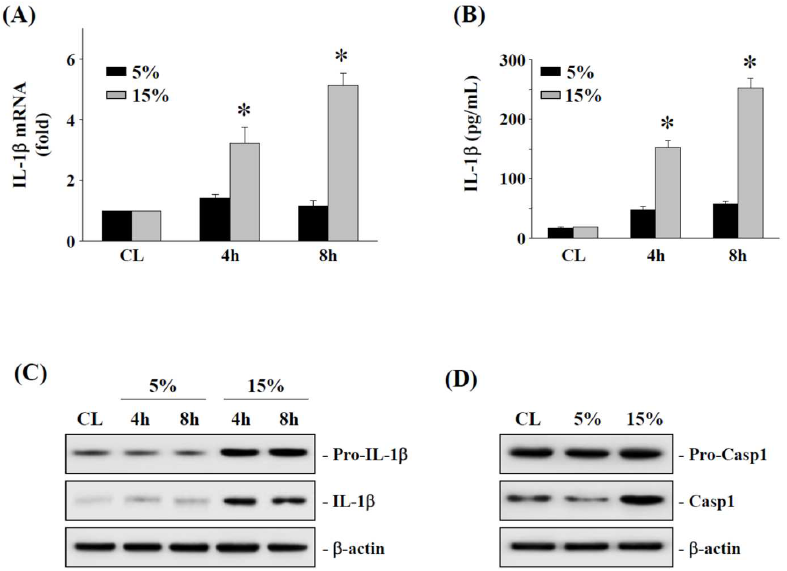
Figure 2. Induction of IL-1β expression in HAFCs exposed to 15% HCS. HAFCs were exposed to 5% or 15% cyclic stretch for the indicated times, and ( A ) the expression level of IL-1β mRNA were determined by real-time PCR analysis. ( B ) IL-1β secretion in medium was determined by ELISA analyses. The results are mean ± standard error of the mean (SEM). * p < 0.05 versus CL. ( C , D ) The expressions of pro-IL-1β and IL-1β ( C ), or pro-caspase-1 and caspase-1 ( D ) in HAFC lysate, were determined using Western blotting. Bars in ( C , D ) are the mean and SEM fold change in band density relative to control, normalized to total protein levels from three independent